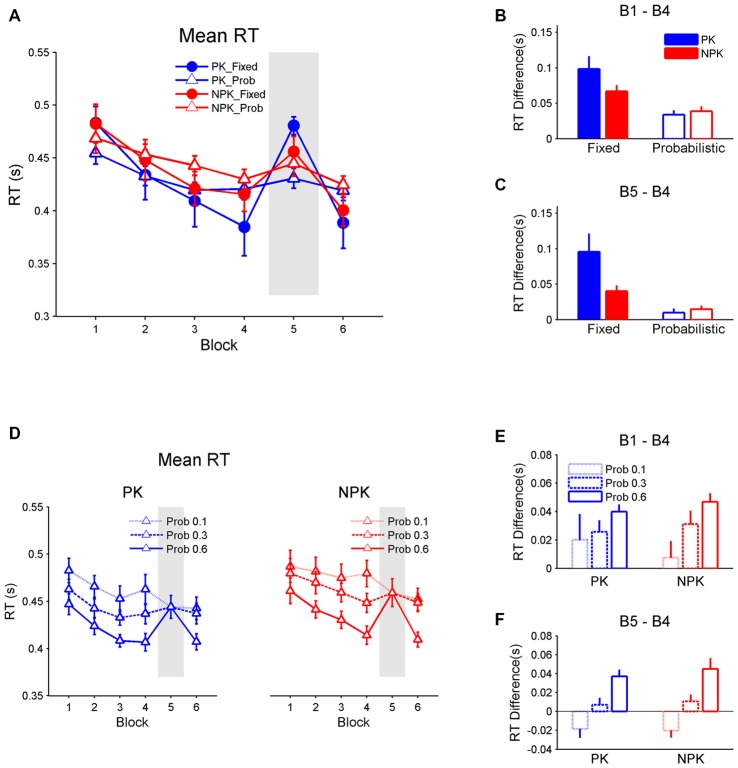
(A) Mean RT and SE bars across the six blocks for all four groups. (B) Difference between the RT in block 1 and block 4 to assess whether sequence learning occurred. (C) Difference between block 5 and block 4 to assess whether RT increases in block 5 when a random sequence is presented. (D) Mean RT and SE bars across the six blocks for only the probabilistic sequence in which the three transitional probabilities (Pro 0.1, Pro 0.3, and Pro 0.6) have been extracted and plotted separately. (E) Difference between RT in block 1 and block 4. (F) In block 5 and block 4 separated for the three transitional probabilities in the probabilistic sequence. PK, preliminary knowledge; NPK, no preliminary knowledge; RT, reaction time; SE, standard error.